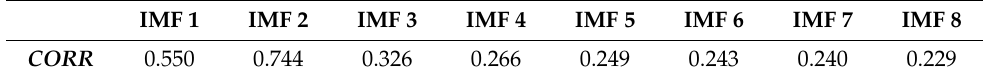
Table 4. Correlation coefficients of the